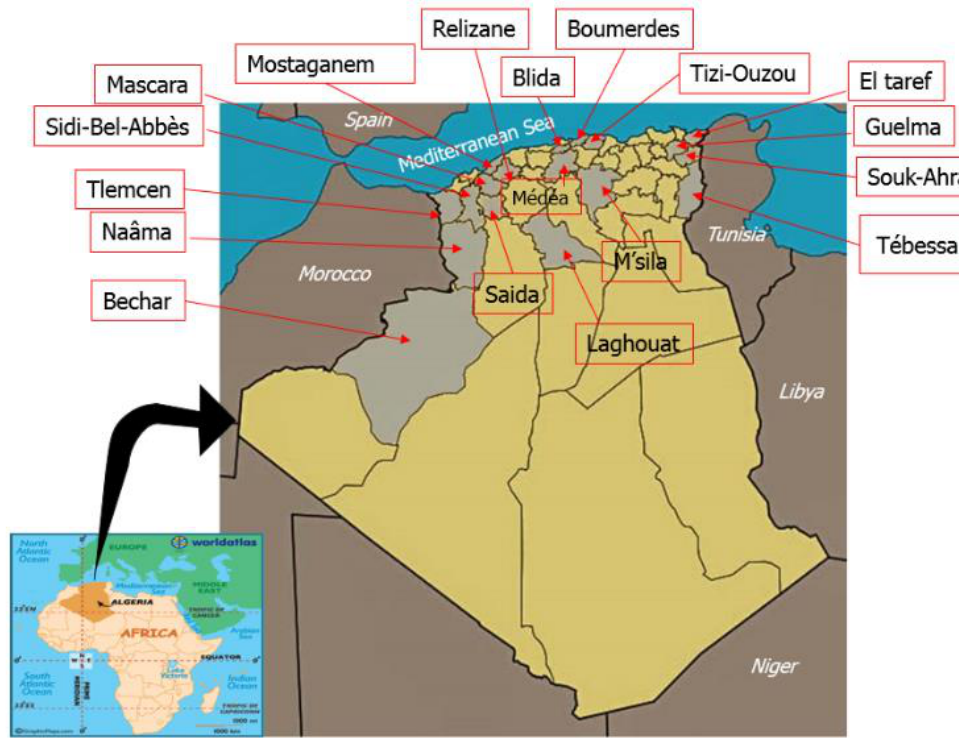
Figure 1. Geographical areas where the samples were taken. Table 1. Geographical origin of samples, climate, and harvest period.